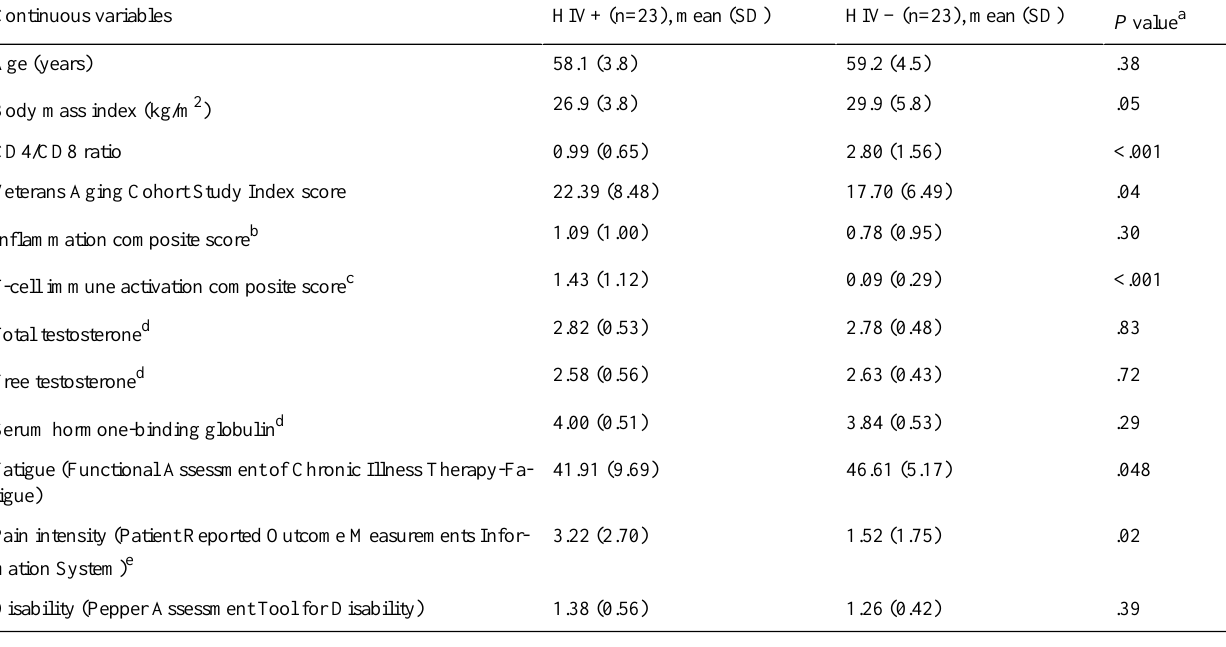
Table 1. The baseline characteristics of the study participants (continuous variables).